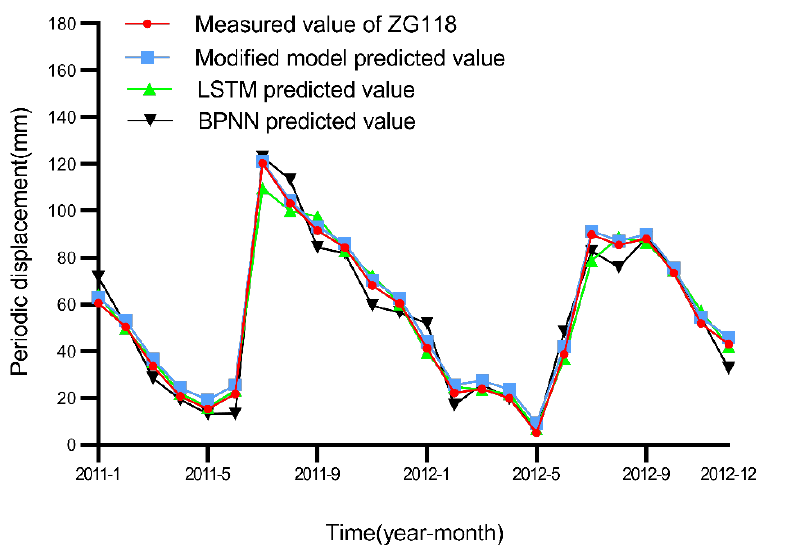
Figure 19. Periodic displacement predicted results of ZG118 using LSTM-FC, LSTM and BPNN models.